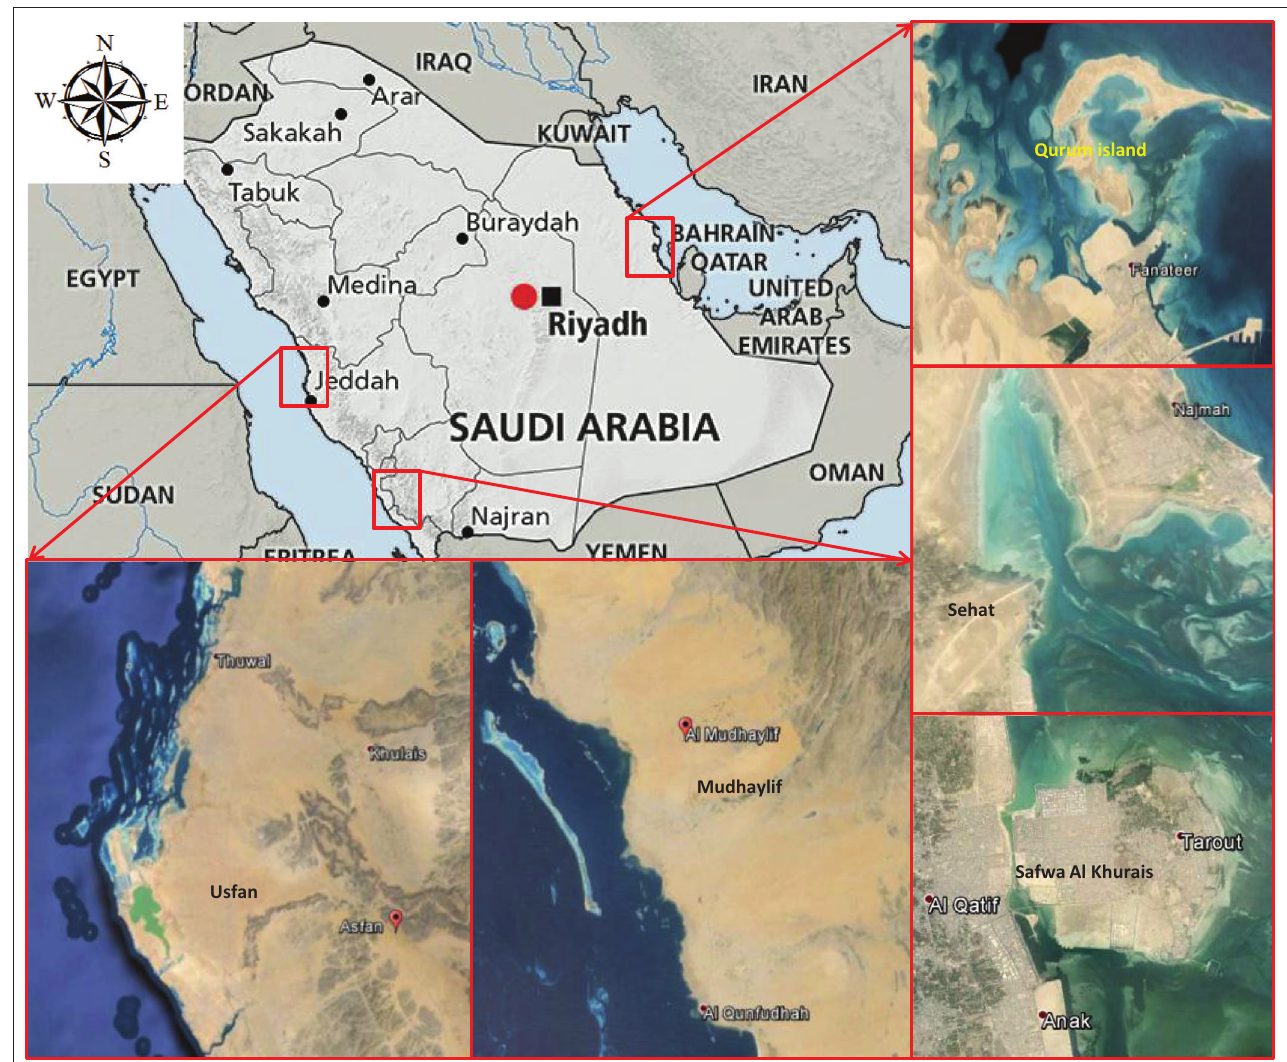
FIGURE 1: The location of the five study sites in the Red Sea (Usfan and Al Mudhaylif) and the Arabian Gulf (Qurum Island, Sehat and Safwa Al